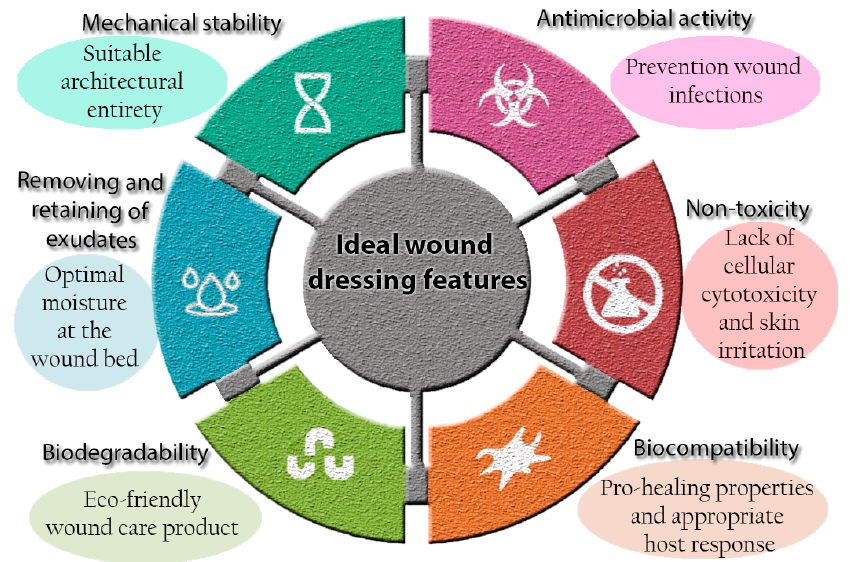
Figure 2. The features of the ideal wound dressing.